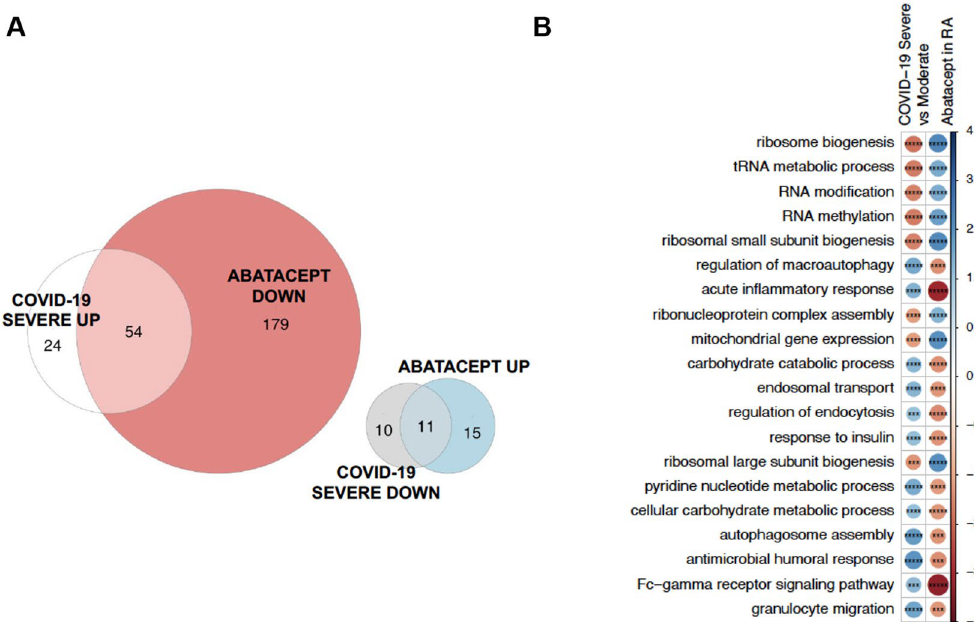
Figure 3. Biological processes distinguishing COVID-19 severe and moderate patients and modified by treatment with abatacept. Severe COVID-19 associated processes represent processes dysregulated in severe COVID-19 patients compared to moderate patients in the late cohort. ( A ) Multiple Venn plot showing the biological processes significantly modified by each exposure (FDR < 0.05) and the resulting disjoint combinations. From the overlapping processes, 100% were found to be modified antagonistically by abatacept. ( B ) Top 20 biological pathways that show a higher level of antagonism between COVID-19 exposure and treatment with abatacept. FDR-adjusted P-values from the two analyses are combined using Fisher’s method, and the resulting combined P-value are used as a ranking measure of antagonism. Blue indicates upregulation and red downregulation of the pathway as measured by the GSEA Normalized Enrichment Score, which is also reflected in the circle size. FDR-corrected P-value levels are indicated as *< 0.05, **< 0.005, ***< 0.0005, ****< 0.00005 and *****<